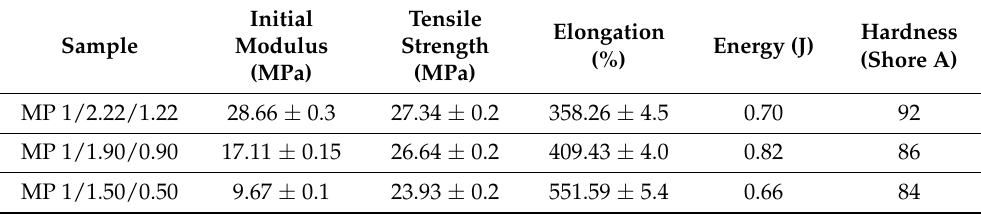
Table 9. Mechanical properties and hardness values of the bio-based